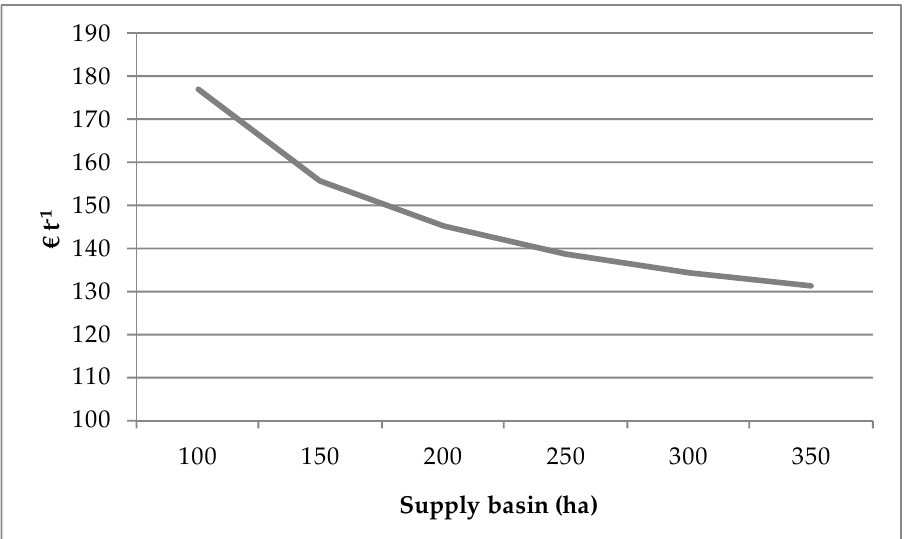
Figure 4. Total pellet production cost according to supply basin.